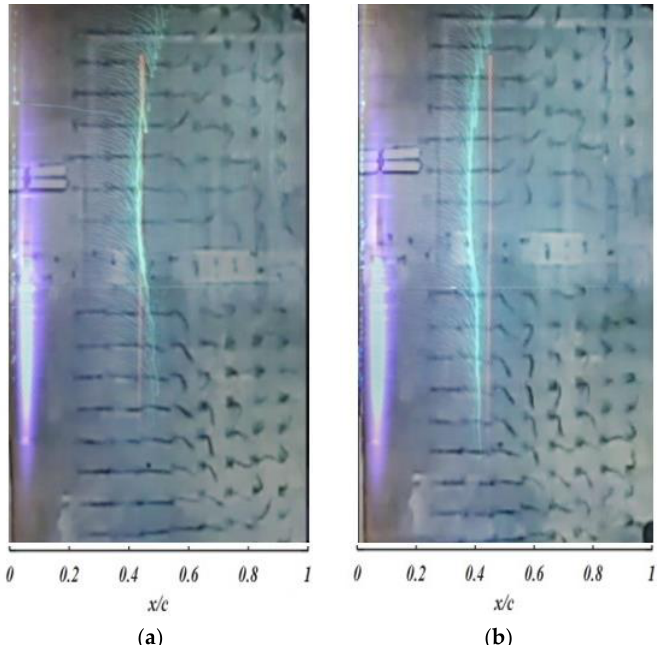
Figure 8. Superposition of oil flow and tuft visualization ( a ) α = 14° and ( b ) α = 16°. Re = 0.5 × 10 6 .